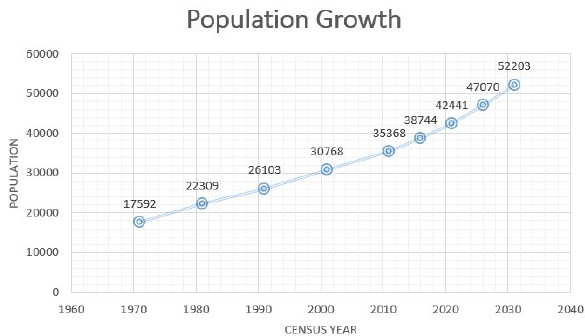
Figure 8. Mehmedabad’s population growth trend